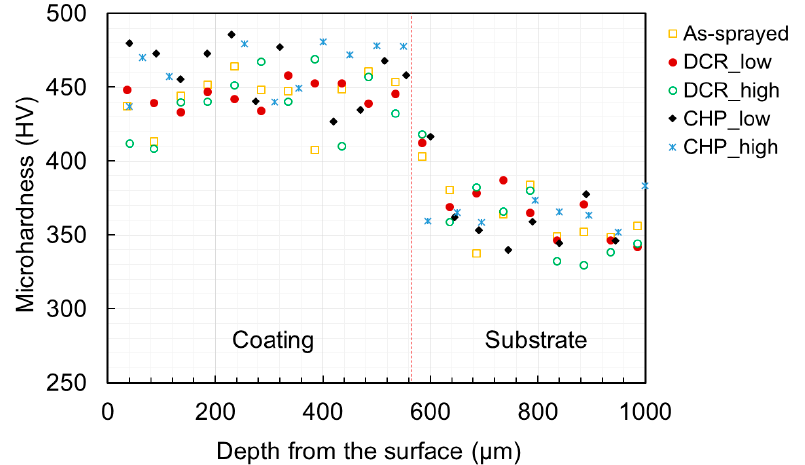
Figure 8. Graph showing variation in hardness along the depth.